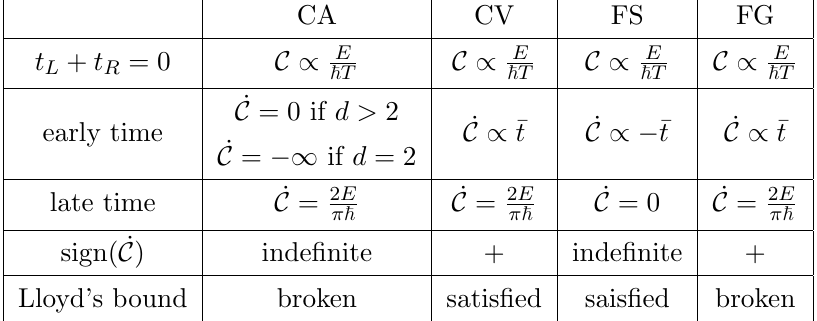
Table 2 . The summary of the complexity between the time-dependent TFD state and its corre- sponding vacuum state in four di(cid:11)erent methods. (cid:22) t = t L + t R and E is the total energy of the system. We have set ‘=‘ AdS = 4 (cid:25) 2 ~ = ( d (cid:0) 1) for the CV conjecture, ‘ 0 = 2 d=(cid:25) for the FG method, and the speed of light c =